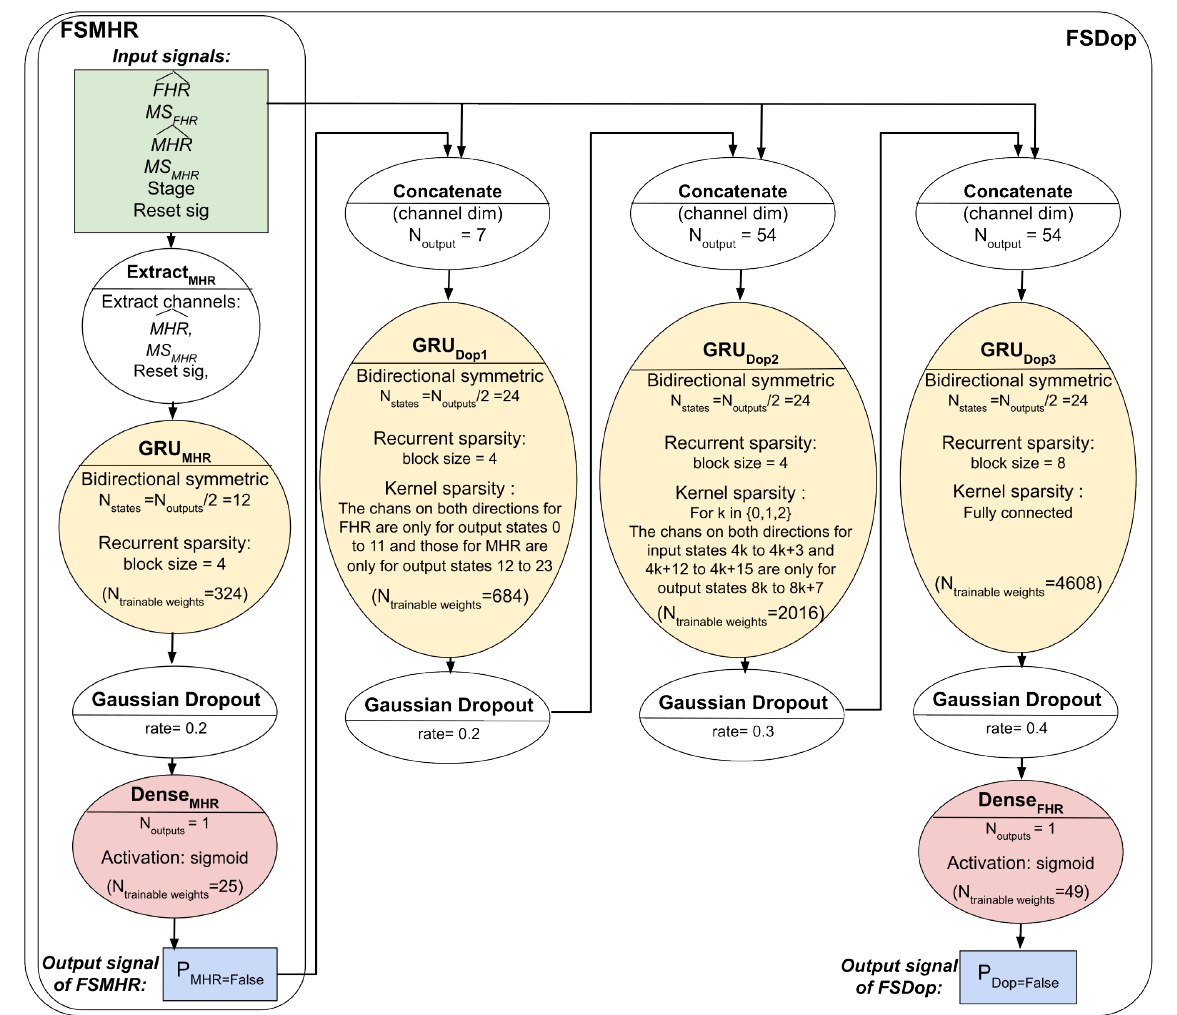
Figure 4. The FSMHR and FSDop models’ architectures and hyperparameters. For each MHR signal sample, FSMHR outputs the probability of being an FS and for each Doppler FHR signal sample, FSDop outputs the probability of being an